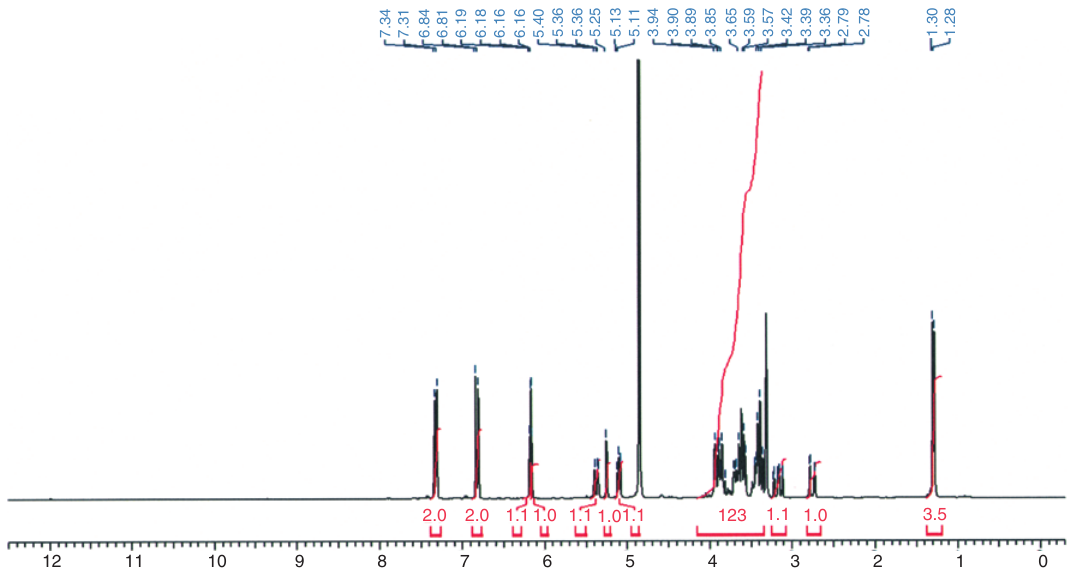
OD, 400 MHz) of extracted naringin. 3